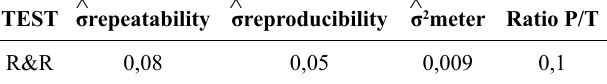
Table 4 - Data of the variables of the σ 2 measurement error for the reliability of the second